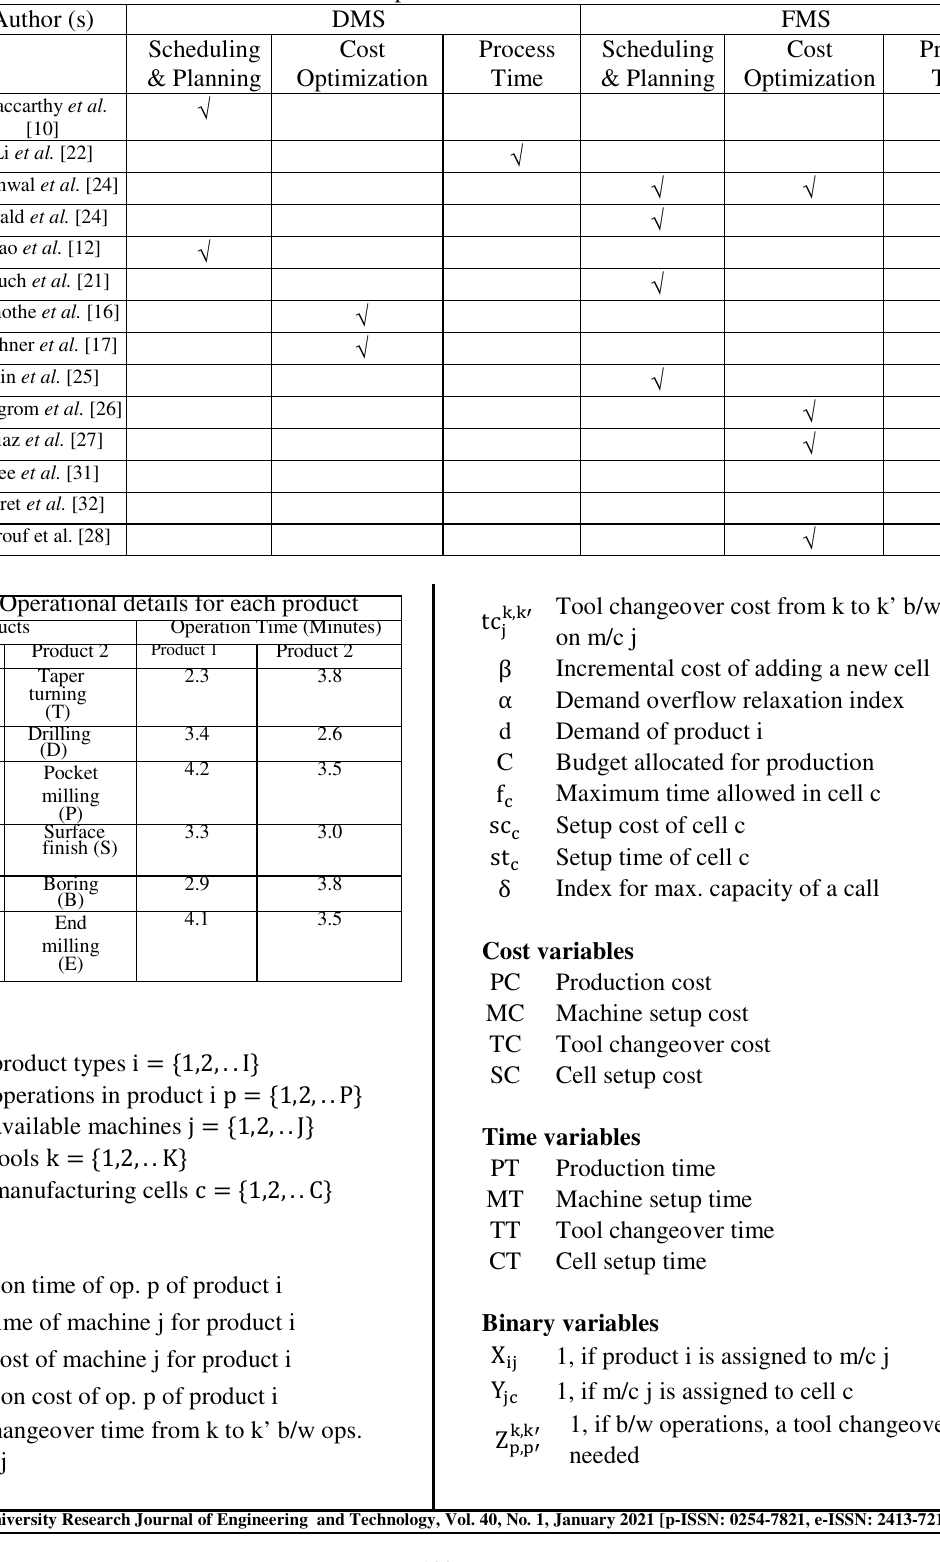
Table1: A review on optimization focus in DMS and FMS literatures